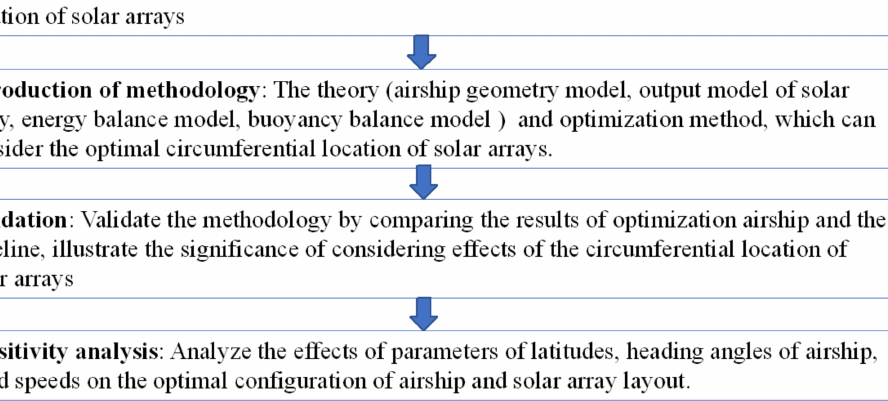
Figure 1. Research plan.